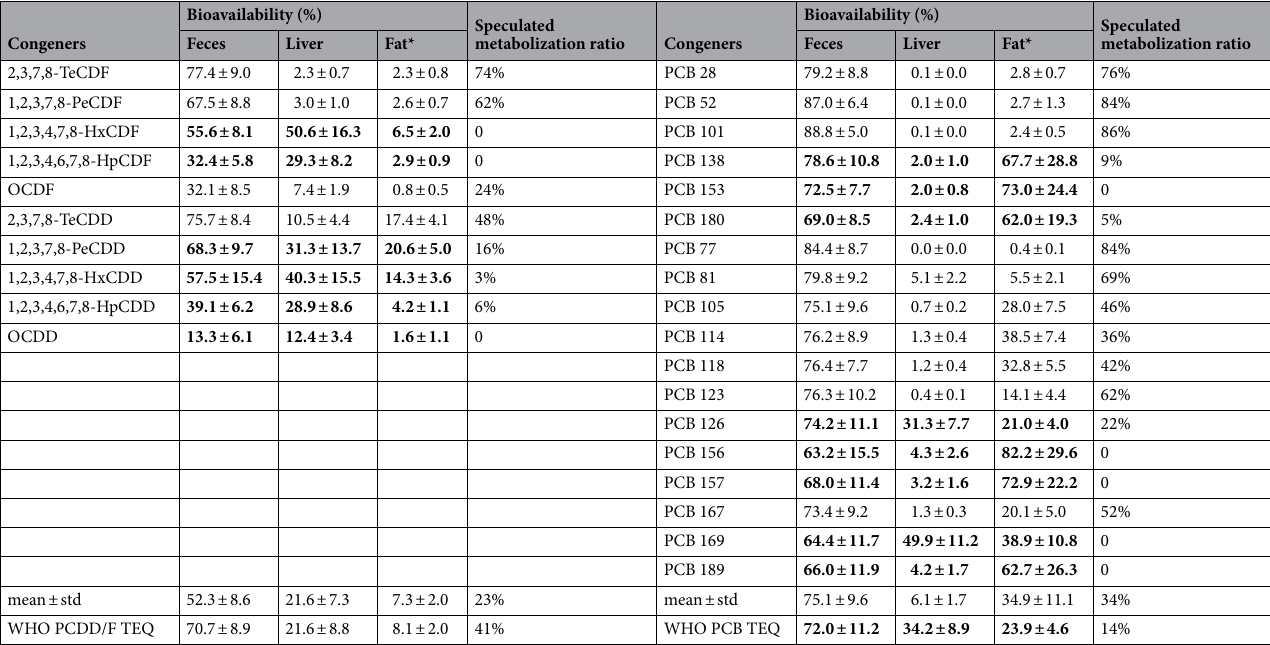
Table 1. PCDD/F/PCB congener bioavailability obtained by different endpoints (mean ± std). Bold values: bioavailability values basing on fecal endpoint were close to the sum of liver and fat endpoints. Speculated metabolization ratio: equals bioavailability values of fecal endpoint minus the sum bioavailability values of liver and fat endpoints. *Estimated whole SD rat body adipose tissue weight, multiplying body fat index (6.5%) by each rat’s weight.